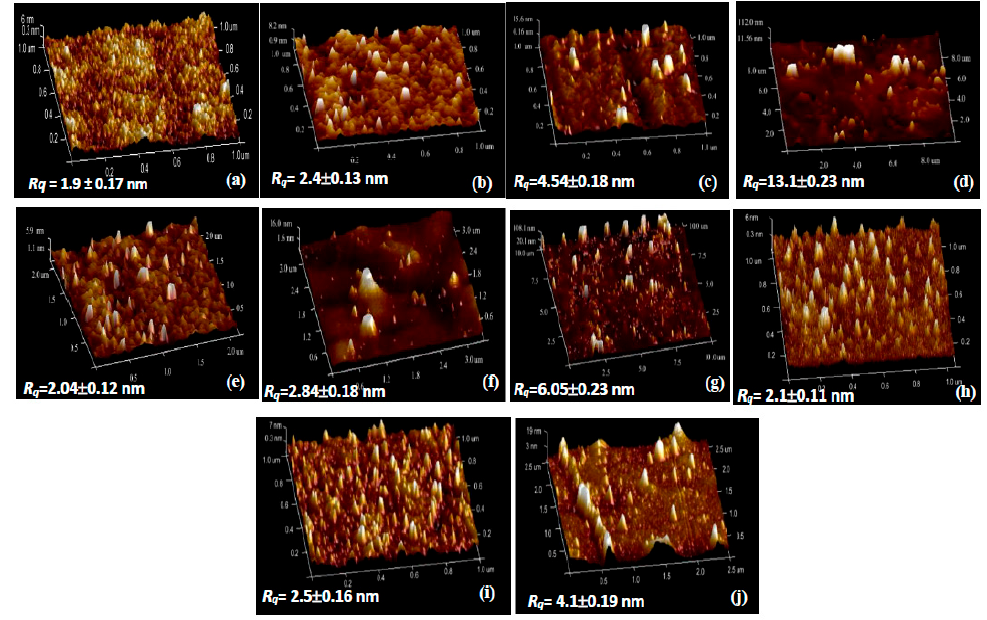
Figure 4. 3D AFM height mapping images of ( a ) PVA and PVA bionanocomposites reinforced with ( b ) 3 wt % HNTs, ( c ) 5 wt % HNTs, ( d ) 10 wt % HNTs, ( e ) 3 wt % Cloisite 30B clays, ( f ) 5 wt % Cloisite 30B clays, ( g ) 10 wt % Cloisite 30B clays, ( h ) 3 wt % NBCs, ( i ) 5 wt % NBCs, and ( j ) 10 wt % NBCs.